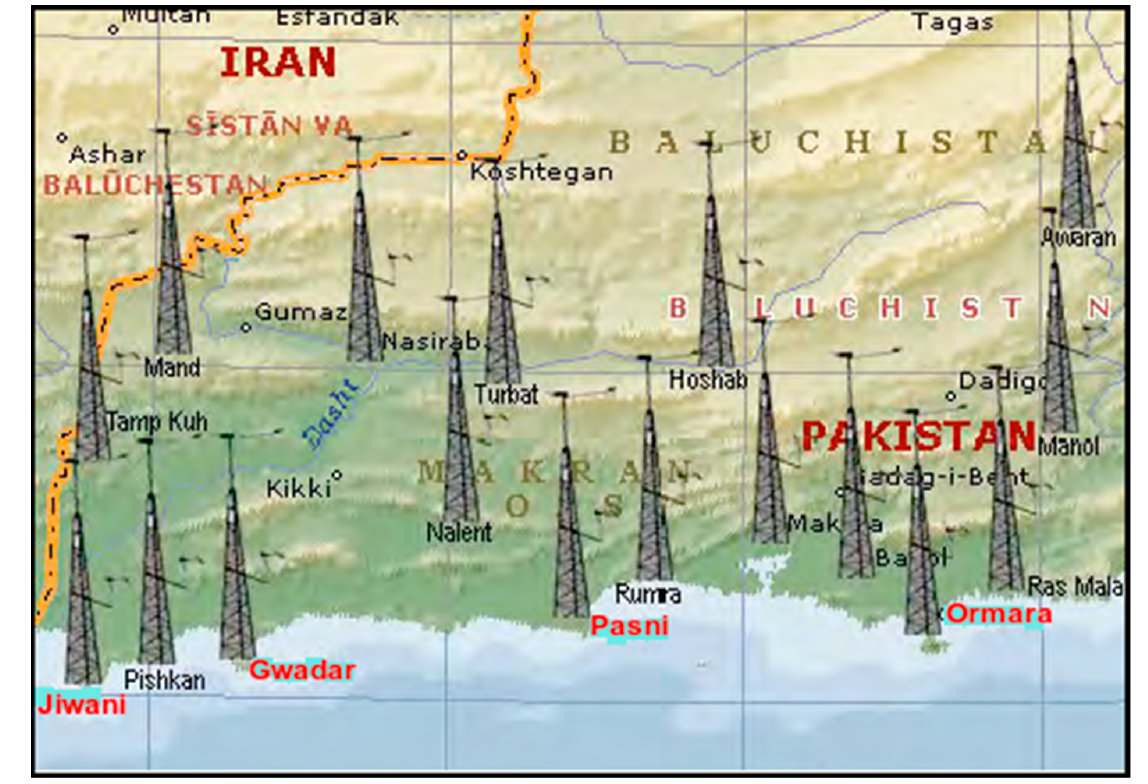
Figure 1. Proposed wind energy sites in Pakistan [13].